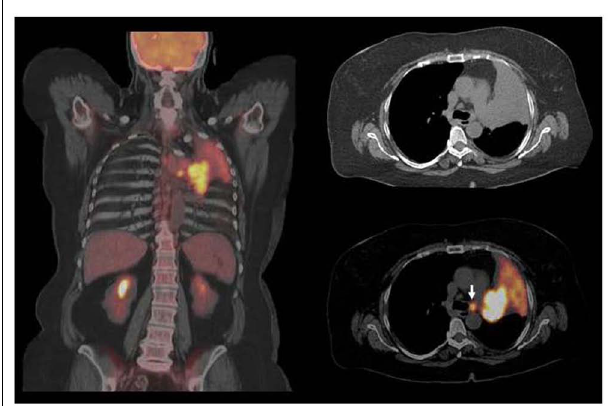
FIGURE 1 | Squamous cell carcinoma in left upper lobe with associated atelectasis. F18 FDG PET/CT shows large hypermetabolic suprahilar mass with a small FDG avid left paratracheal lymph node metastases. F18 FDG PET/CT defines the extent of metabolically active tumor and differentiates viable tumor from adjacent atelectasis. FDG avid solitary mediastinal lymph node metastases were also detected by PET/CT while CT was equivocal. However, the major impact of PET/CT was for guiding GTV with incorporating metabolically active tumor and nodal metastases and excluding atelectatic lung tissue in order to deliver higher dose to the tumor and decrease radiation to normal lung.